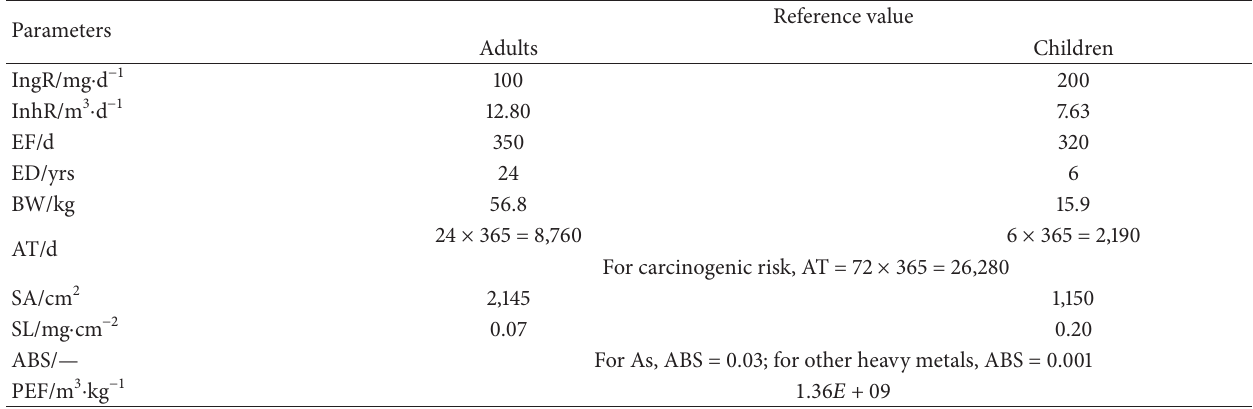
Table 2: Variables used to assess human exposure to the soil.